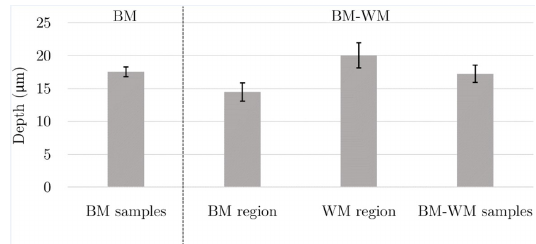
Figure 15. Crevice depth measured with 2D roughness equipment in the BM and BM-WM after the crevice tests. ‘BM-WM samples’ represent the mean depth along the surface, made up of both the base material, HAZ, and WM regions. ‘BM region’ and ‘WM region’ represent the corrosion mean depth in the base material and in the weld metal of welded samples measured separately. Error bars indicated de confidence intervals (Student